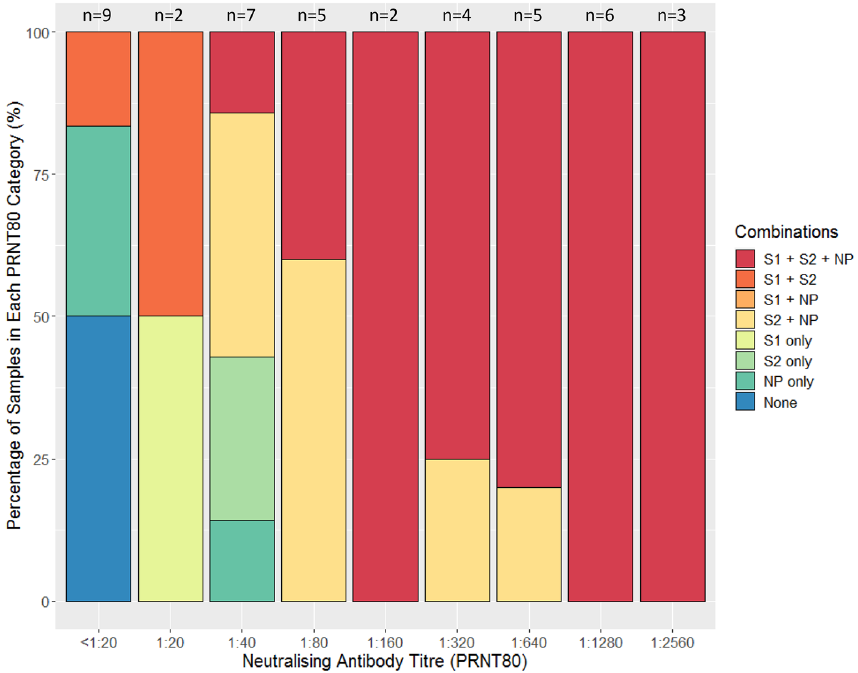
Figure 3. Percentage of samples in PRNT 80 categories binding to different antigen combinations by Western Blot. S1 spike protein subunit 1, S2 spike protein subunit 2, NP nucleocapsid